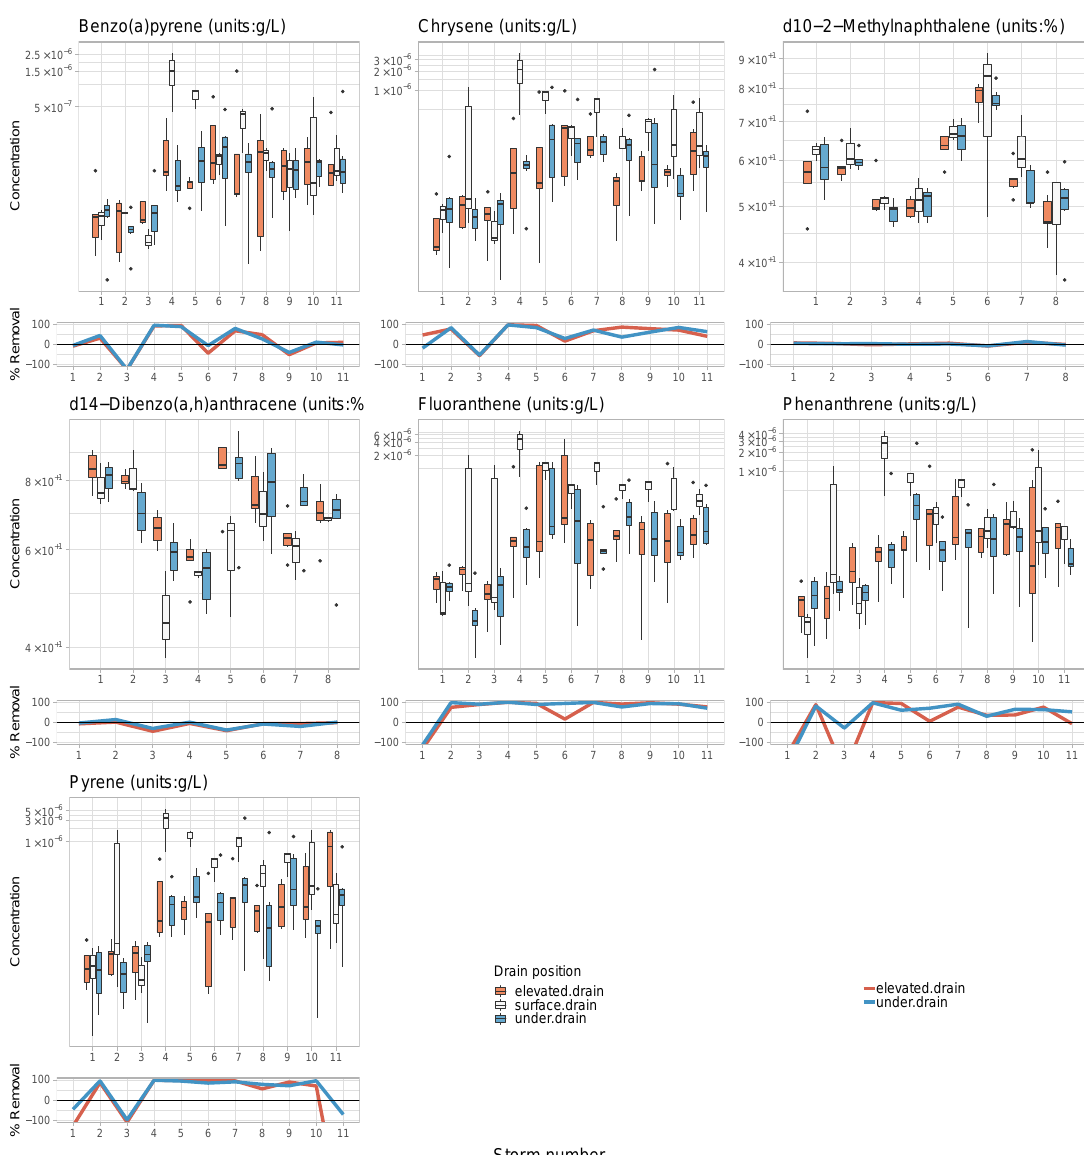
Figure 6. Removal efficiencies for PAHs at elevated drain and under drain positions across measured storms. Removal efficiencies below − 100% (or over 100% export) are not shown, and why some line graphs appear